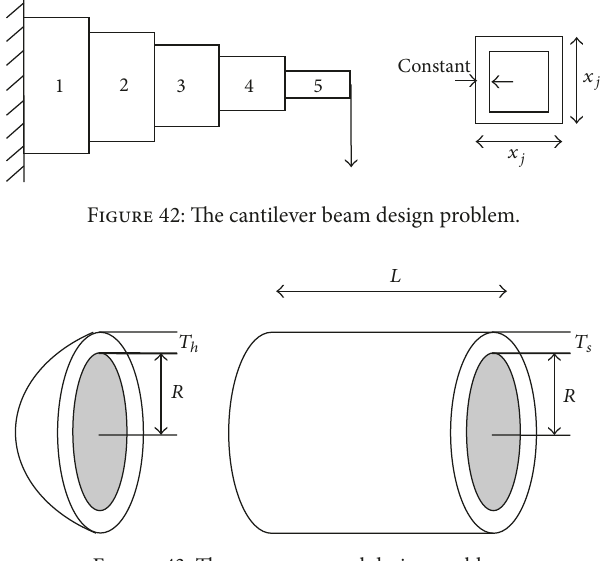
Figure 43: The pressure vessel design problem.